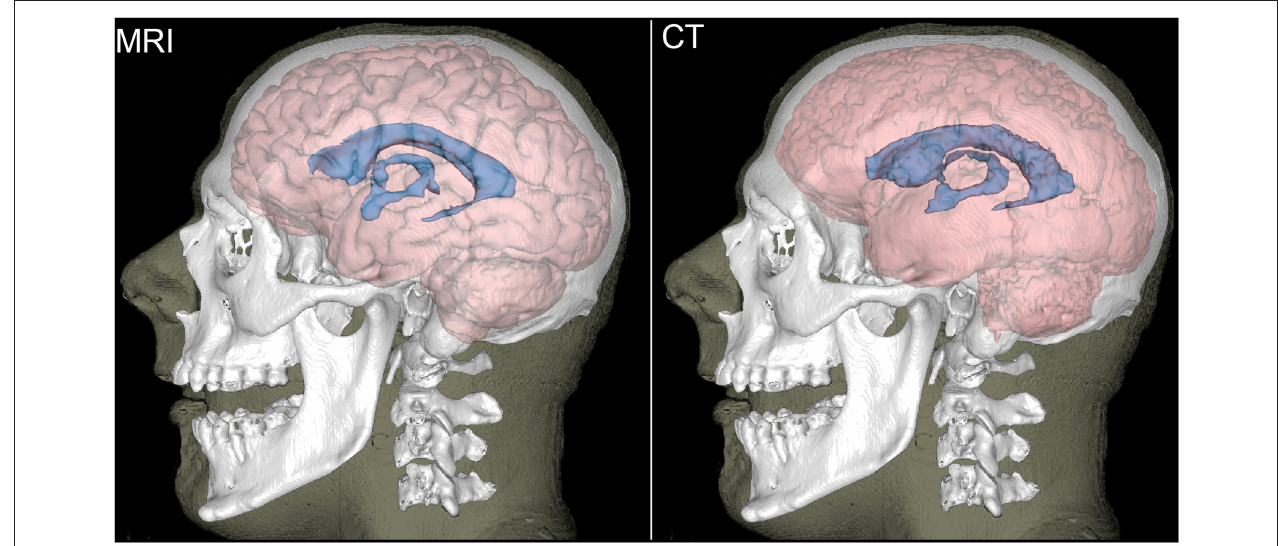
FIGURE 2 | Reconstructions of the brain (light red), ventricular CSF (blue), bones (white), and skin (translucent) for a representative participant. The brain and ventricular CSF are based on MRI (left) and on CT (right) . Bones and the skin surface were reconstructed from CT.